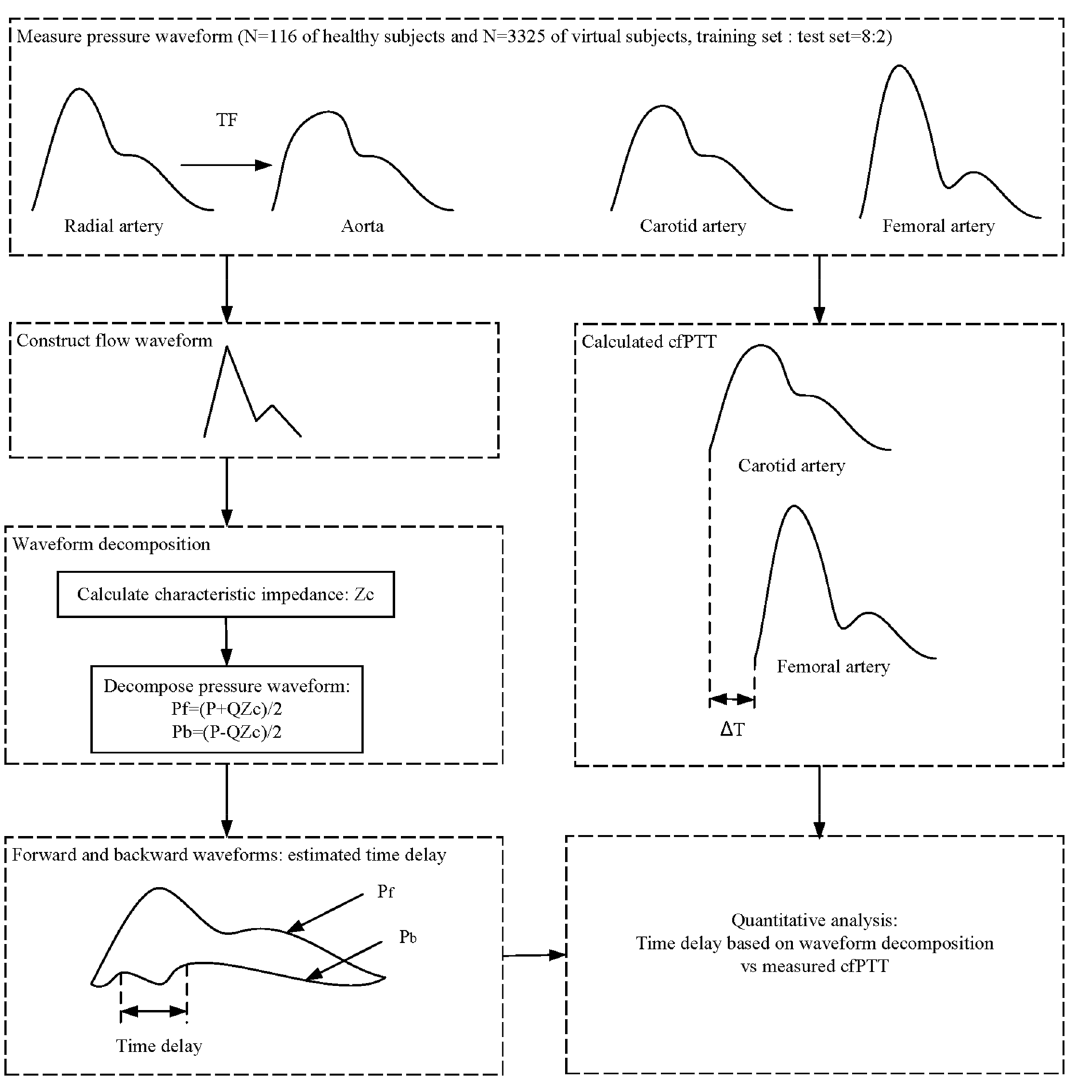
Figure 1. The block diagram of the time delay estimation